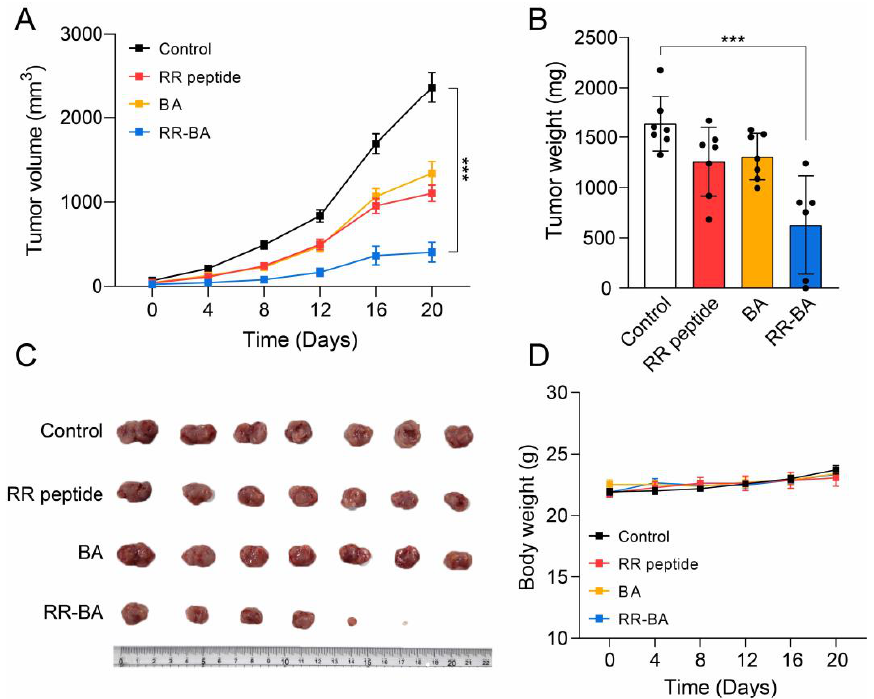
Figure 7. Tumor inhibitory effect in the CT26 tumor-bearing mice. ( A ) Tumor volume change. ( B ) Tumor weights on the last day of the experiment. ( C ) Isolated tumors after sacrifice. ( D ) The body weights of tumor-bearing mice. *** Denotes statistically significant differences in comparison with the saline-treated group (control).